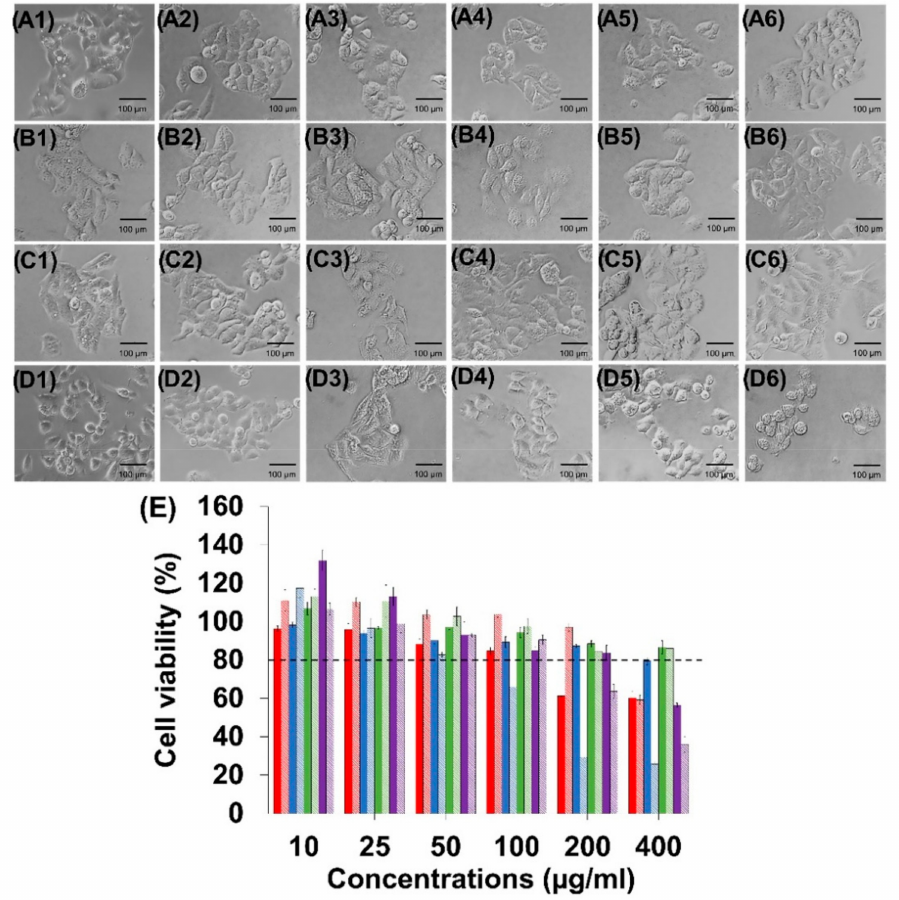
Figure 1. Cell survival and cytotoxicity testing of the HepG2 cells. ( A ) Morphology was exposed to different concentrations (( A1 ): 10 µ g/mL; ( A2 ): 25 µ g/mL; ( A3 ): 50 µ g/mL; ( A4 ): 100 µ g/mL; ( A5 ): 200 µ g/mL; and ( A6 ): 400 µ g/mL) of C. fenestratum from water extraction. ( B ) Morphol- ogy was exposed to different concentrations (( B1 ): 10 µ g/mL; ( B2 ): 25 µ g/mL; ( B3 ): 50 µ g/mL; ( B4 ): 100 µ g/mL; ( B5 ): 200 µ g/mL; and ( B6 ): 400 µ g/mL) of Z. officinale from water extraction. ( C ) Morphology was exposed to different concentrations (( C1 ): 10 µ g/mL; ( C2 ): 25 µ g/mL; ( C3 ): 50 µ g/mL; ( C4 ): 100 µ g/mL; ( C5 ): 200 µ g/mL; and ( C6 ): 400 µ g/mL) of C. tinctorius from water extraction. ( D ) Morphology was exposed to different concentrations ( D1 ): 10 µ g/mL; ( D2 ): 25 µ g/mL; ( D3 ): 50 µ g/mL; ( D4 ): 100 µ g/mL; ( D5 ): 200 µ g/mL; and ( D6 ): 400 µ g/mL) of medicinal recipe containing C. fenestratum : Z. officinale : and C. tinctorius extracted with water in a ratio of 3:2:1. ( E ) MTT assay of HepG2 cells treated with different concentrations of the C. fenestratum (Water extract: red bar and Ethanolic: red stripes), Z. officinale (water extract: blue bar and ethanolic: blue stripes), C. tinctorius (water extract: green bar and ethanolic: green stripes), and Recipe (water extract: purple bar and ethanolic: purple